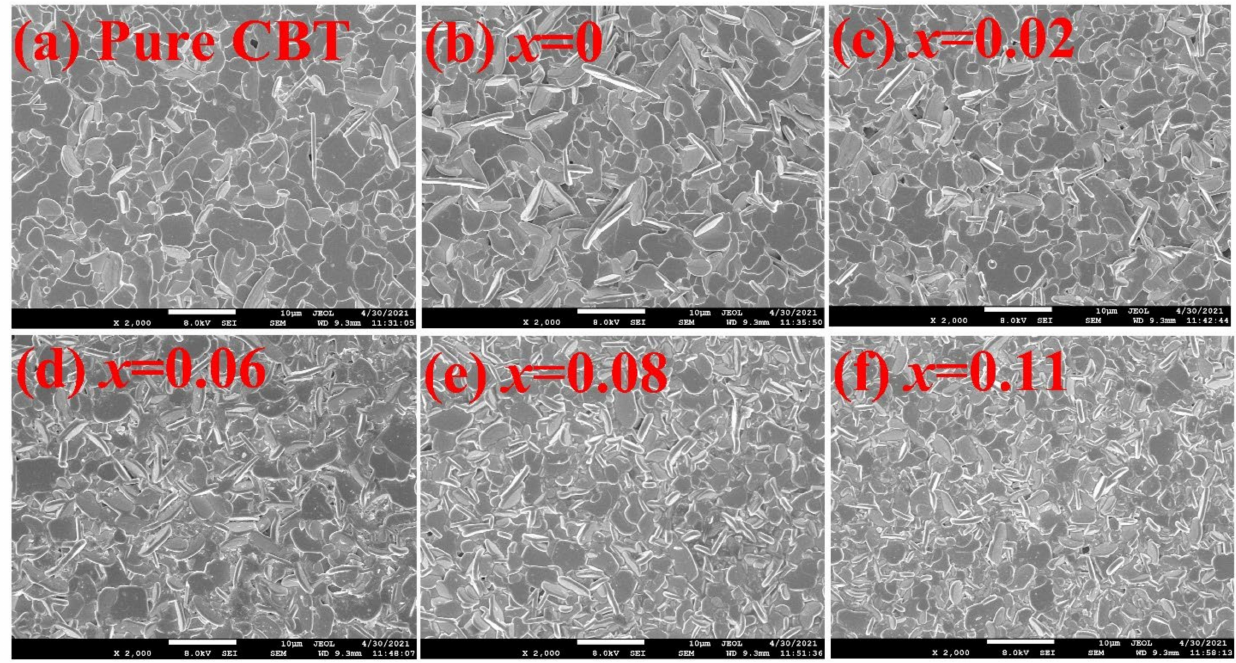
Figure 2. SEM images focused on the original surfaces of the CBT − x Gd/0.2Mn ceramics. In order to explore the grain characteristics of the CBT- x Gd/0.2Mn piezoceramics quantitatively, the linear intercept method (performed by the Nano Measurer software) was used to obtain the grain size distribution from SEM images, the results were shown in Figure 3. When x increased from 0 to 0.11, the average grain size ( D λ ) gradually decreased from 2.65 µ m to 2.30 µ m, and the corresponding size distribution became more inhomogeneous. Among the CBT- x Gd/0.2Mn piezoceramics, the composition with x = 0.11 had the smallest grain size ( D λ = 2.30 µ m) and the widest size distribution; such refined grains and compact structure could reduce the oxygen vacancy concentration and improve the activation energy of grain boundary, so as to provide a higher poling electric field to the ceramic. Alternatively, an obvious grain refinement, which was accompanied by more random grain orientation, occurred in those samples with x (cid:61) 0.08, indicating that enough Gd 3+ entering into the A-site of perovskite unit would influence the growth behav- ior of ceramic grains. This phenomenon could be attributed to the reduced boundary energy for grain boundary migration or the increased activating energy for ion migration